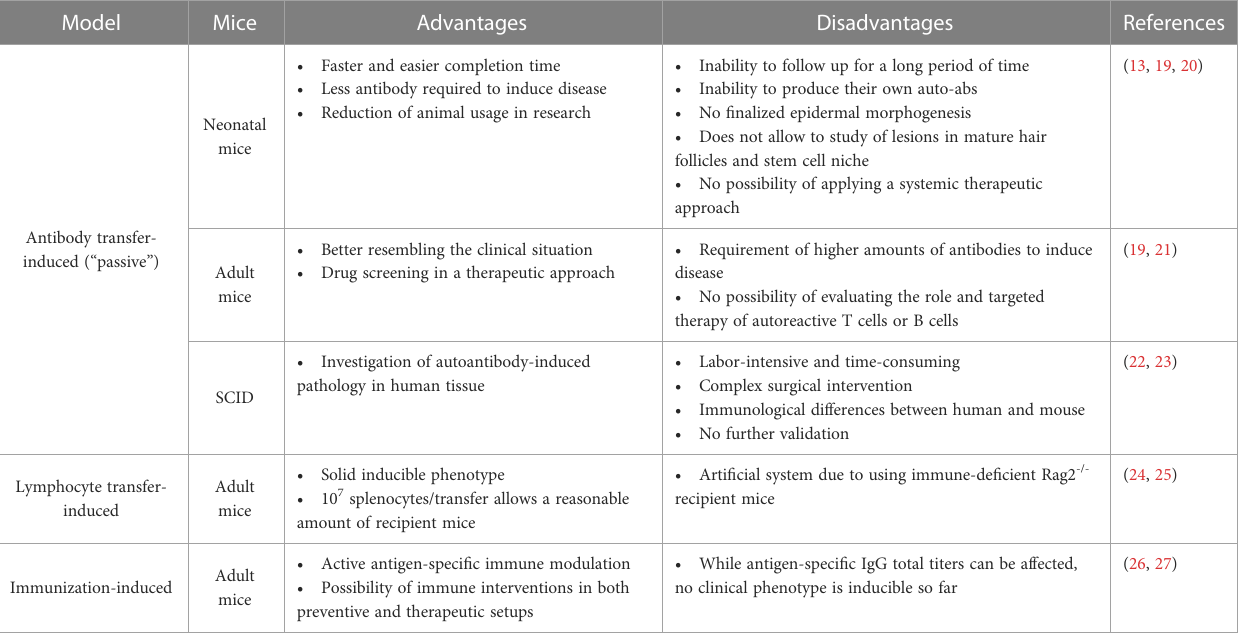
TABLE 1 Advantages and disadvantages of pemphigus mouse